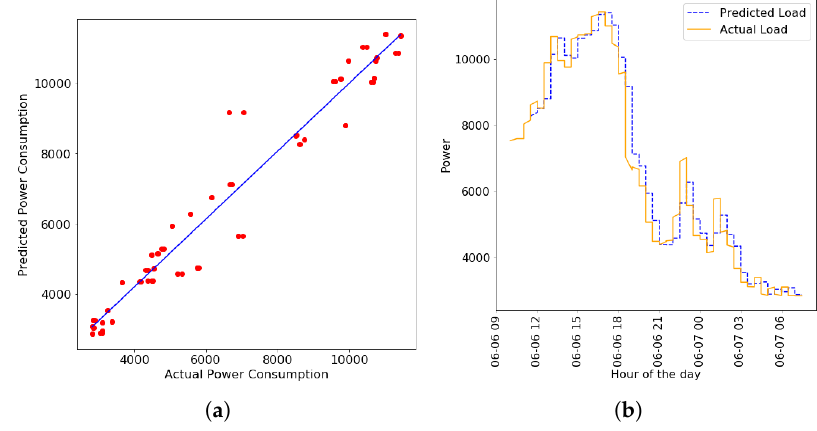
Figure 8. Short Term Forecasting of the Y2E2 lighting load every 30 min period using a linear kernel in GPR. ( a ) Actual v/s Predicted Load for a 20 h period; ( b ) Predicted (blue dashed) and Actual (orange solid) load for a 20 h